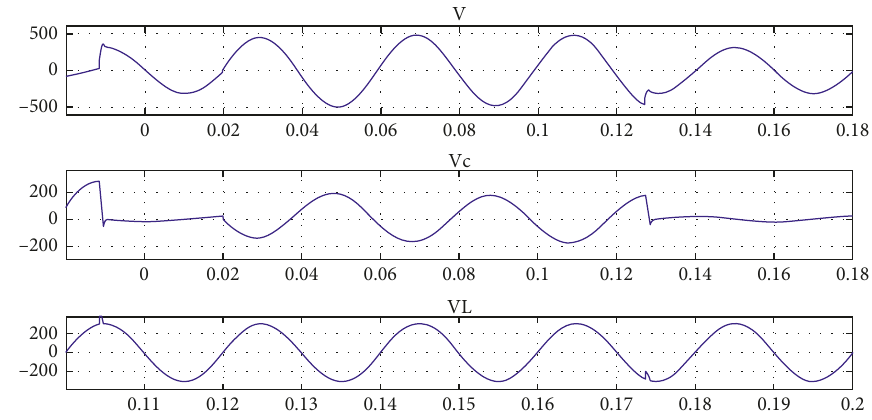
Figure 19: The result of compensating voltage